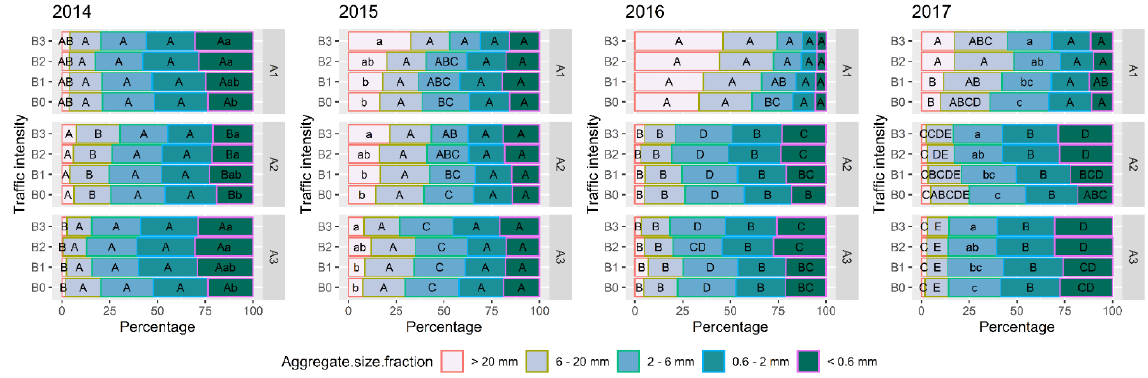
Fig. 3. Percentage of different aggregate size fractions (>20 mm, 6–20 mm, 2–6 mm, 0.6–2 mm, <0.6 mm), affected by timing (Sowing date: A1 = early, A2 = medium, A3 = late) and traffic intensity (B0 = no, B1 = one, B2 = two, B3 = three wheelings) during spring fieldwork in 2014–2017. Different letters indicate significant differences in Tukey comparison within each aggregate size fraction and year, with capital letters for effect of sowing date and interaction between sowing date and traffic intensity, uncapitalised letters for effect of traffic intensity